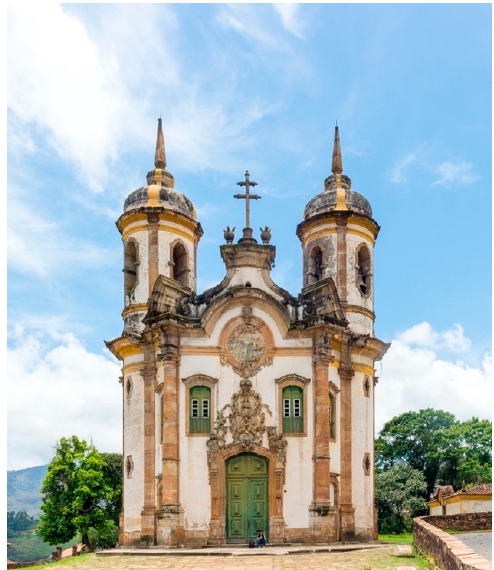
Figure 4. Antônio Francisco Lisboa, São Francisco de Assis Church , Ouro Preto,